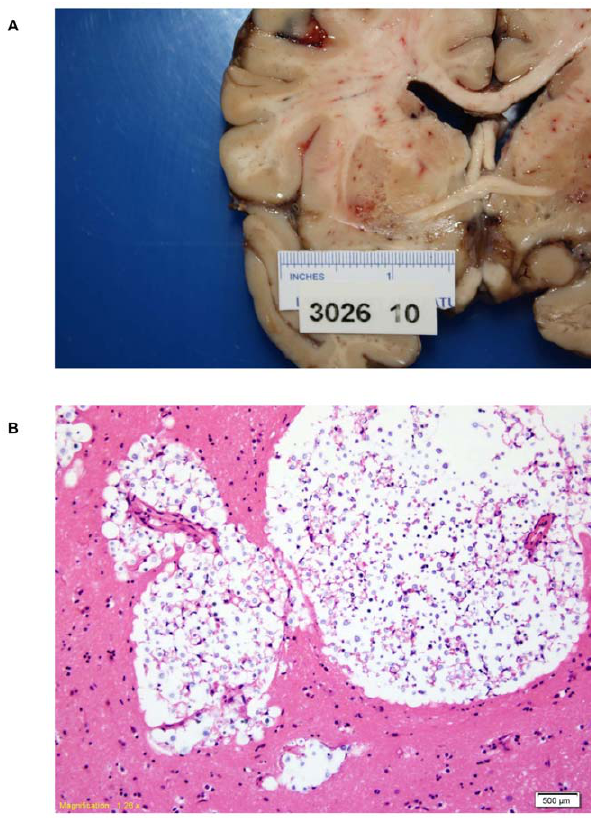
Figure 1. Postmortem examination of the brain demonstrates cryptococcal lesions. a. On gross examination, sections through the cerebral hemispheres demonstrated multiple, small vesicular lesions predominantly in the bilateral basal ganglia and additional lesions scattered throughout the bilateral white matter tracts. No lesions were present in the cerebellum or brainstem. b. On histopathologic exam, hemotoxylin/eosin stained sections of the vesicular lesions showed diffuse clusters of yeast cells.